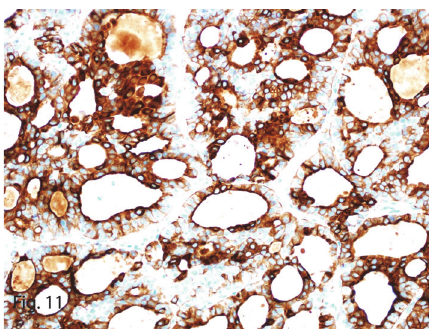
Figure 11: Cytokeratin 7 immunostain with strong and diffuse expression in the neoplastic cells (original magnification × 40).